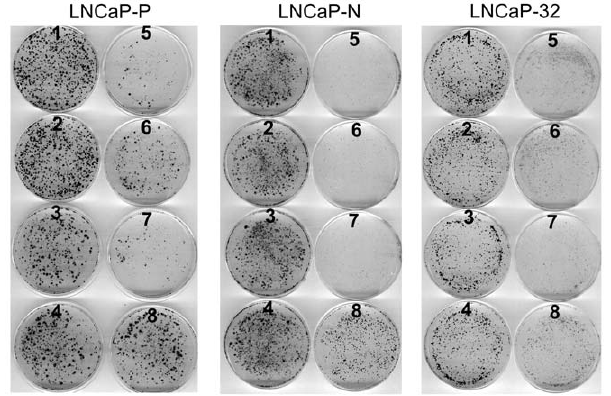
Figure 7. Connexin expression and junction formation accen- tuates the growth inhibitory effect of 9-CRA, ATRA and androgens in LNCaP cells. LNCaP-P, LNCAP-N and LNCaP-32 cells were seeded at clonal density in 6 cm dishes in triplicate as described in Figure 6 legend. After 24 h, cells were treated with 9-CRA, ATRA and MB either alone or in combination. Cells were grown until they formed visible colonies (21 d for LNCaP-P and LNCaP-N and 28 d for LNCaP-32). Medium was changed every 4 d. Colonies were fixed with formalin and stained with crystal violet as described in Materials and Methods. The numbers on the dishes correspond to the following concentrations of 9-CRA, ATRA and MB. 1=control; 2: MB (0.5 nM); 3=9-CRA (0.5 m M); 4. ATRA (0.5 m M); 5=MB + CRA; 6. MB + ATRA; 7=CRA + ATRA (0.5 m M); 8=MB=(1 nM). Note that the combined treatment is more potent and that the growth of LNCaP-32 cells is more profoundly inhibited. controlling PCA progression, epidemiological data have been controversial as both suppressive and stimulatory effects have been reported [24,79–81]. Androgens and retinoids are required for the maintenance of normal healthy prostate epithelium as in their absence glandular atrophy of the prostate ensues due to massive apoptosis of luminal epithelial cells [18,82]. Although retinoids